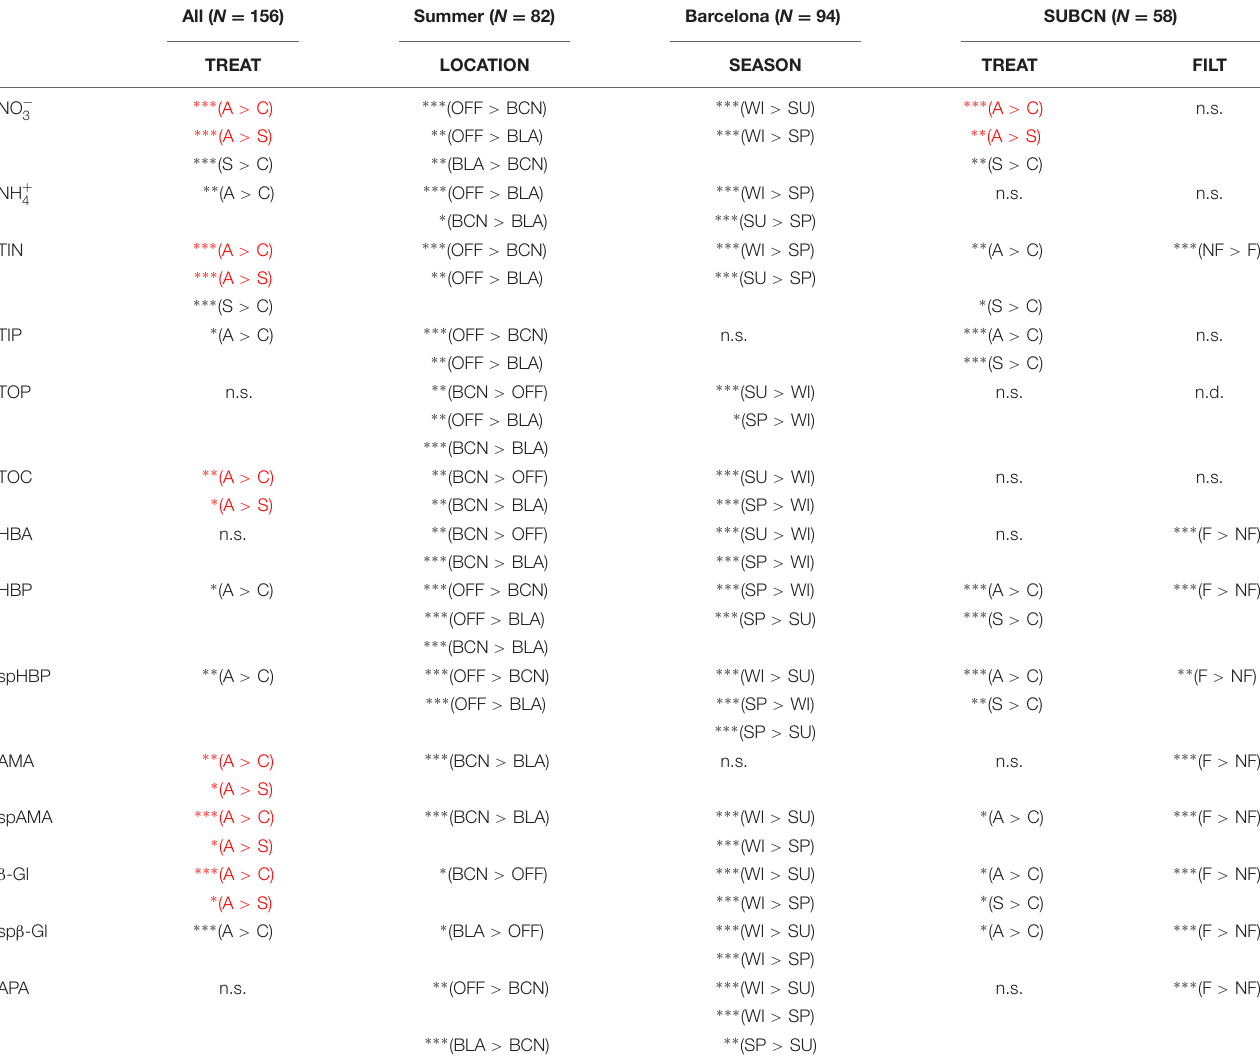
TABLE 3 | Results of the Wilcoxon test for the different comparison assessed. ‘Sp’ refers to specific rates of HBP, AMA, and β -Gl, respectively. All ( N = 156) Summer ( N = 82) Barcelona ( N = 94) SUBCN ( N = 58) TREAT LOCATION SEASON TREAT FILT NO −